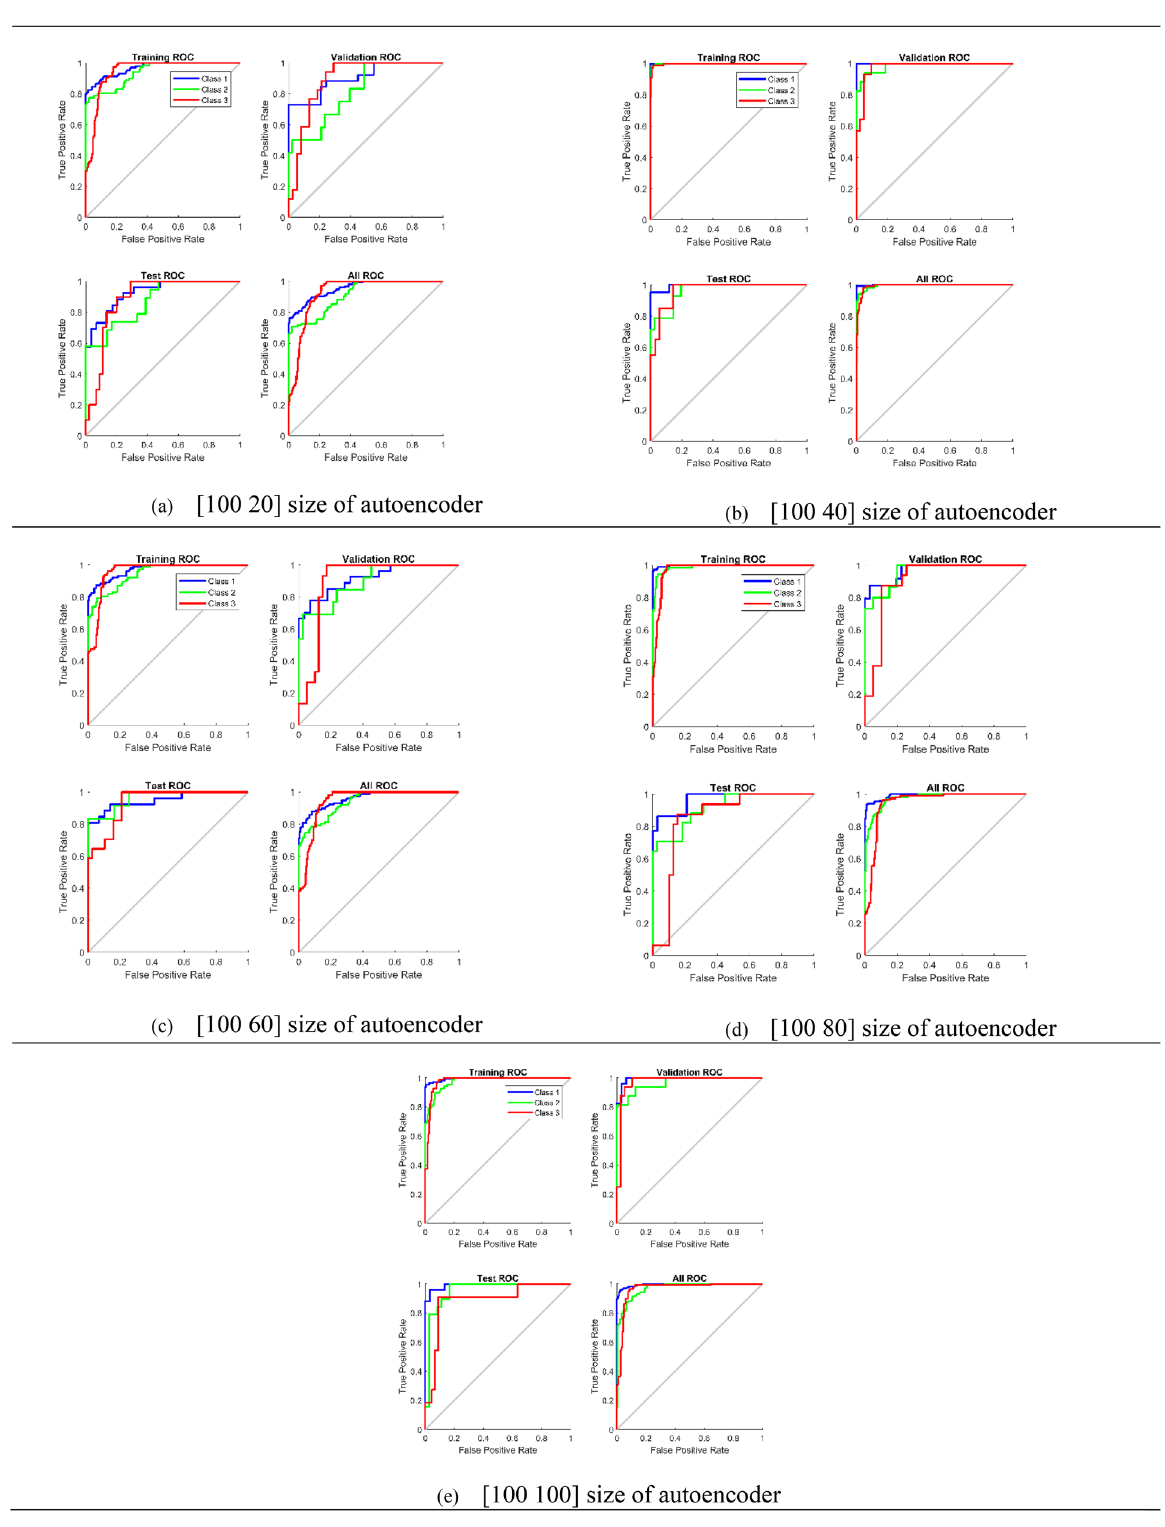
Figure 2. Receiver operating characteristics curves (ROCs) of proposed deep stacked sparse autoencoder neural network with different number of